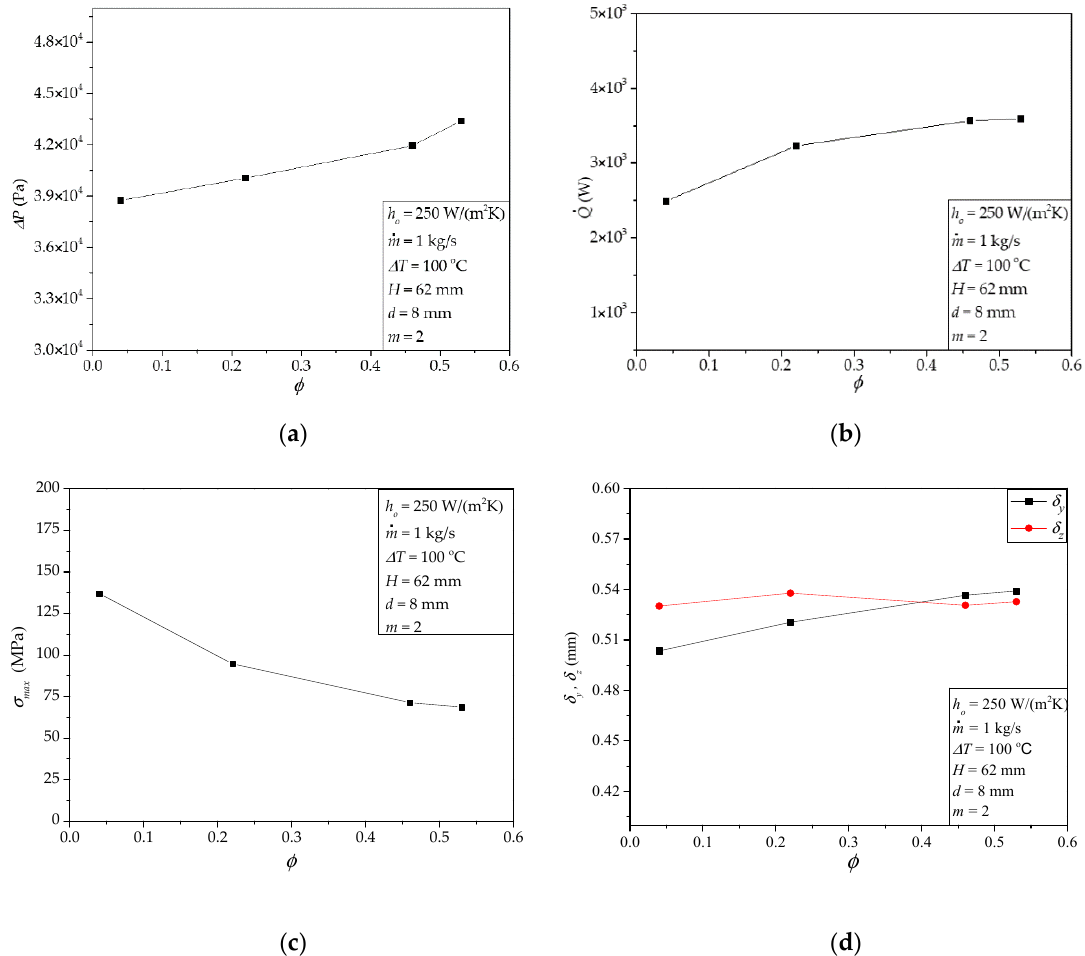
Figure 2. Effects of fluid volume ratio ϕ : ( a ) Δ P , ( b ) Q  , ( c ) σ max , ( d ) δ y , δ z . Figure 2. E ff ects of fluid volume ratio φ : ( a ) ∆ P , ( b ) . Q , ( c ) σ